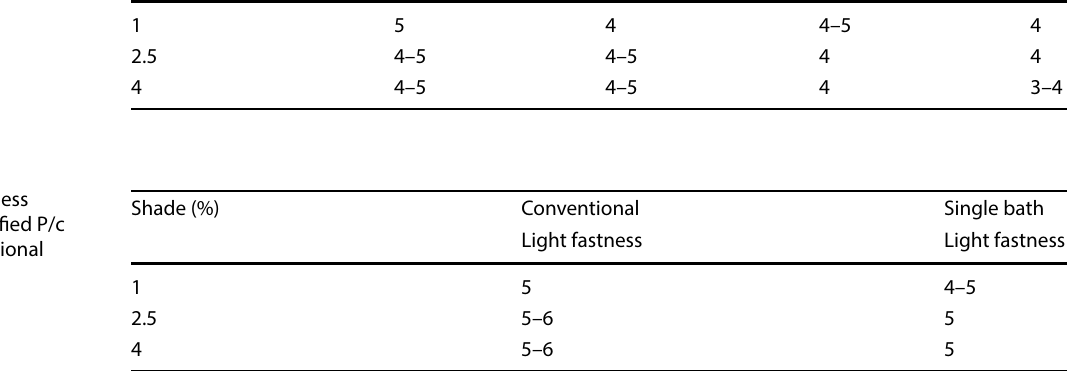
Table 7 Rubbing fastness properties of modified P/c blend and conventional fabric dying